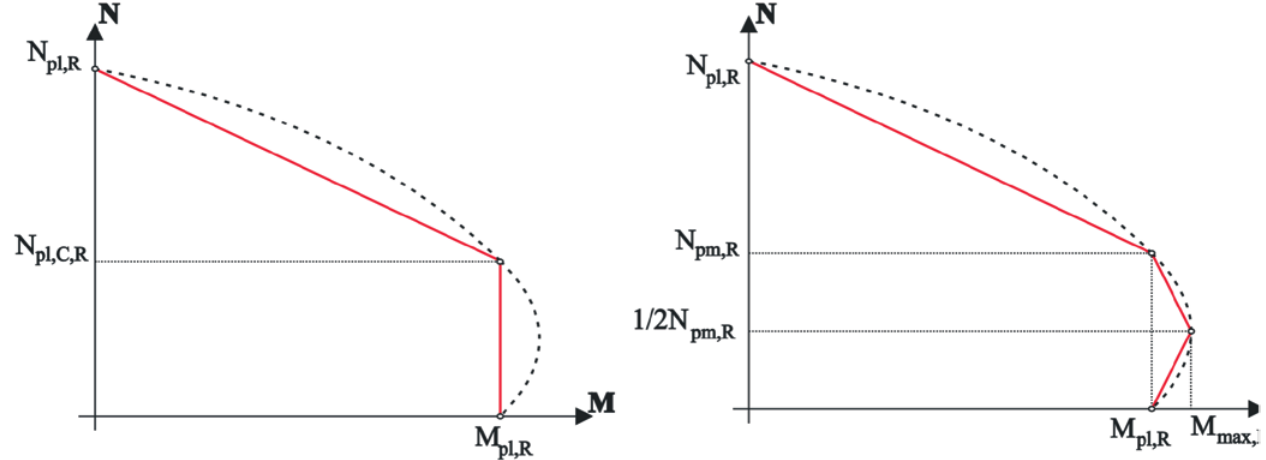
Figure 2 Axial load x bending moment interaction curves for a) Model I and b) Model II